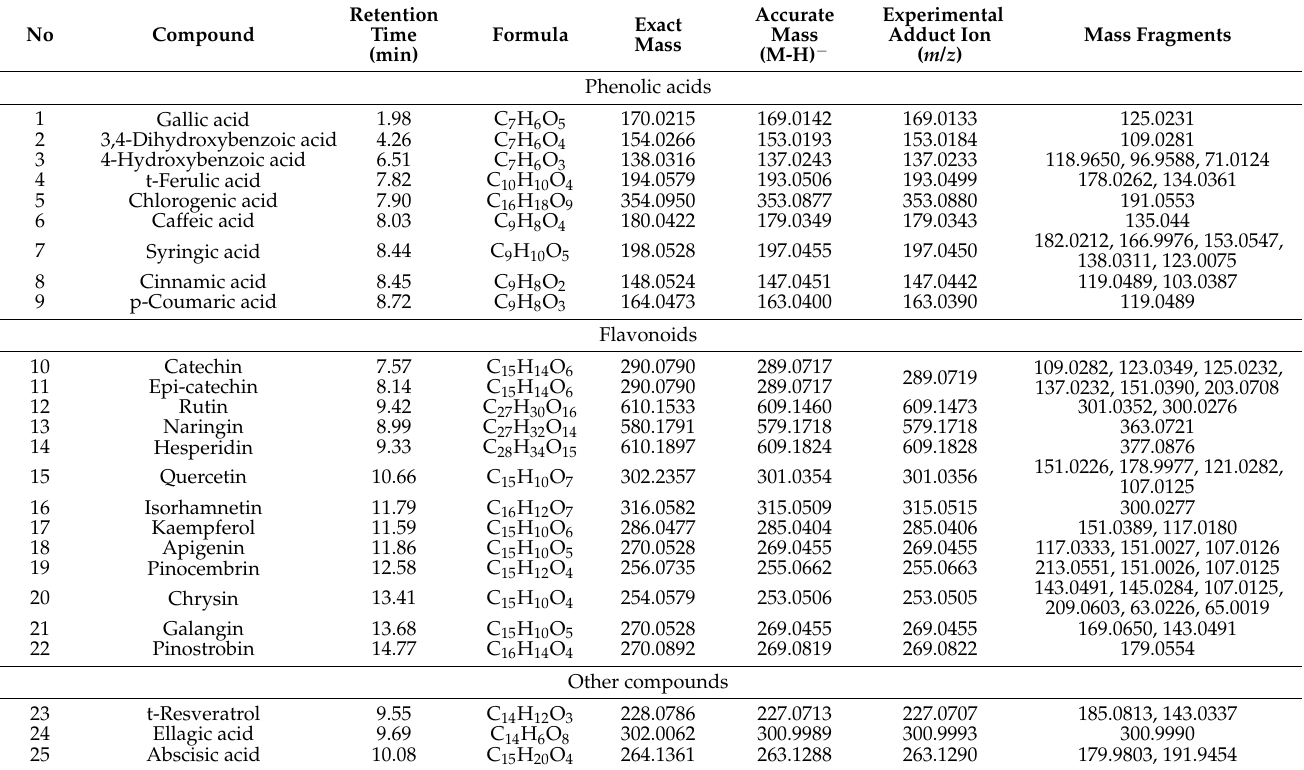
Table 1. The identification of phenolic compounds in grape pomace by UHPLC-HRMS with structures confirmed by comparison with reference standards.